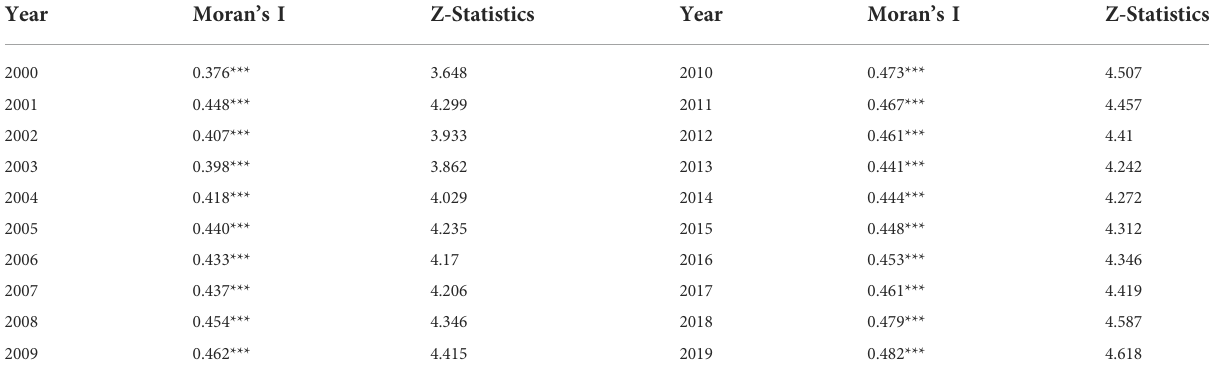
TABLE 2 GE ’ s spatial autocorrelation test.